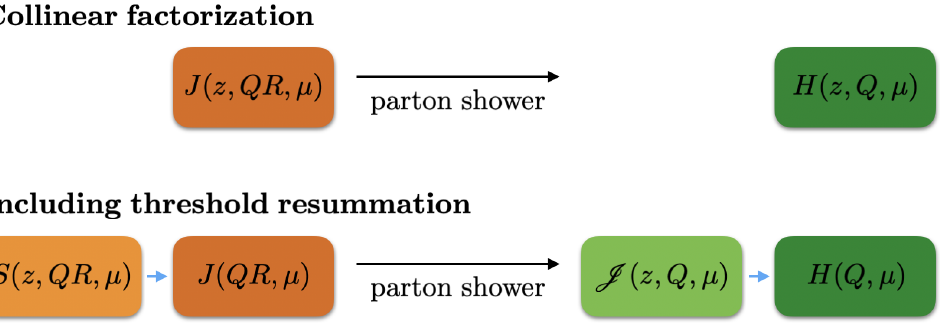
Figure 5 . Comparison of collinear factorization (left) and when threshold resummation is included (right). The evolution indicated by the blue arrows is carried out analytically and in both cases the parton shower resums large logarithms between the scales QR → Q . Functions with the same colored box have the same characteristic